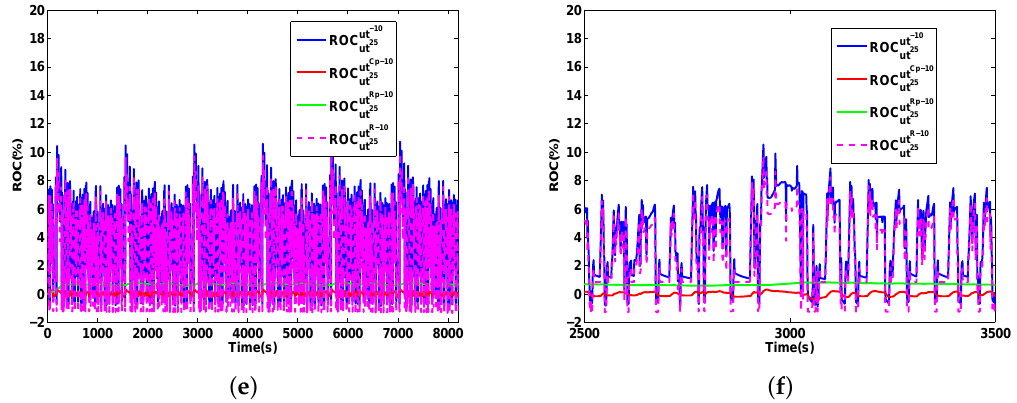
Figure 9. The model output voltage rate of change when the model parameters change: ( a ) with the current of Figure 4a; ( c ) and ( e ) with the alternative current; ( b ); ( d ) and ( f ) are the zoom of ( a ); ( c ) and ( e ),